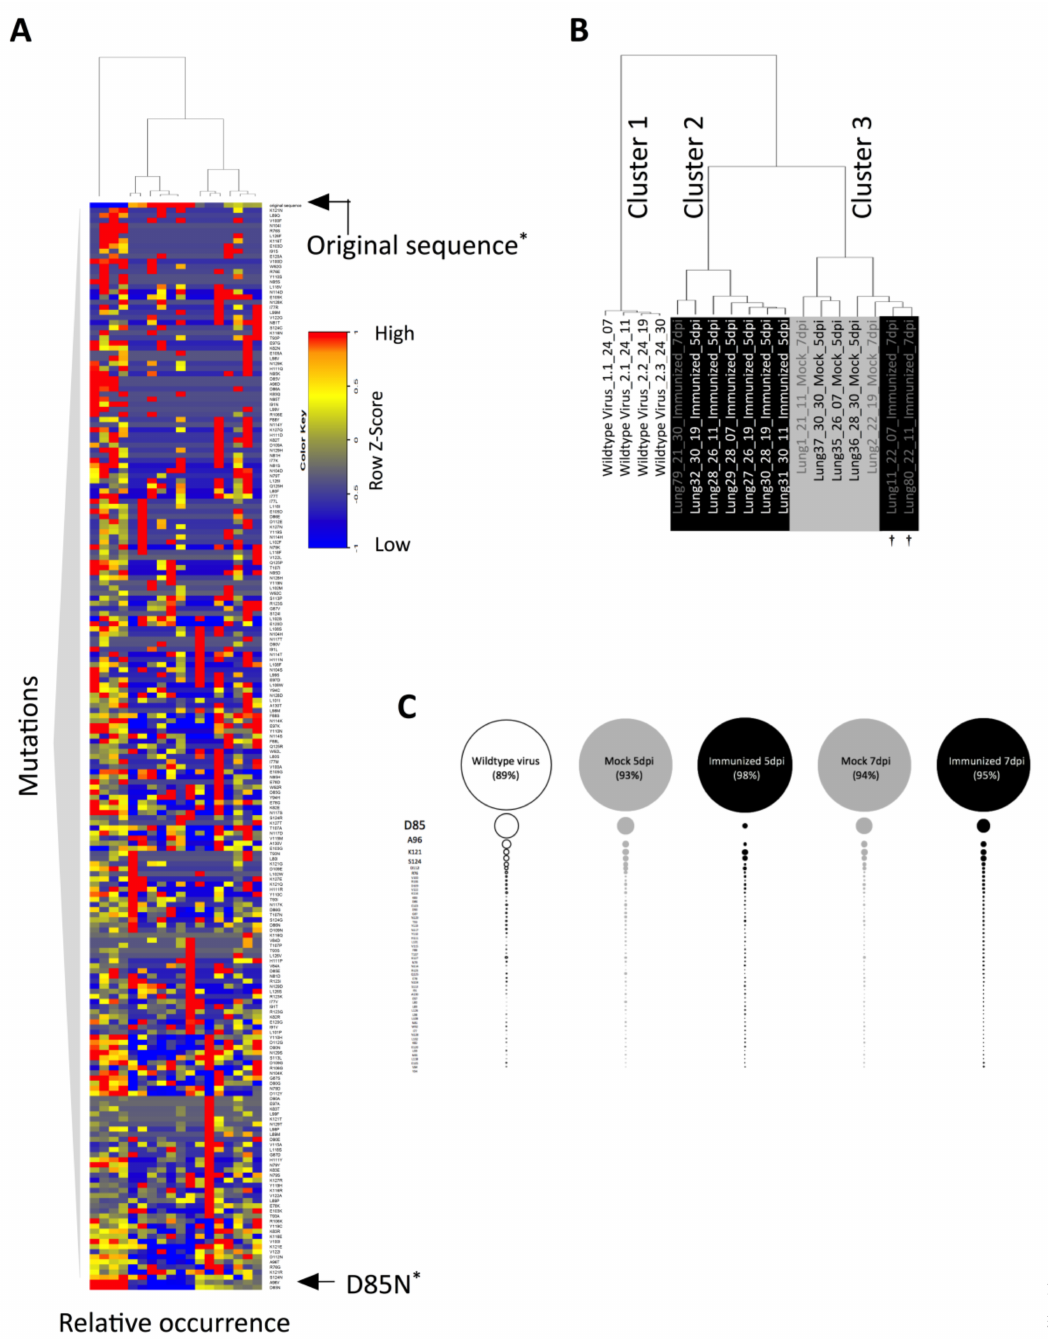
Figure 5. Constrained viral quasispecies evolution under immune pressure. ( A ) Heatmap and dendrogram of missense mutations detected in at least three out of the 18 samples analyzed by Z score based on frequency. Values from each row (i.e., mutation) have been normalized to have a mean of 0 and SD of 1. Relative expression levels of the same mutation within the individual mice are represented by the color code indicated. ( B ) Enlarged dendrogram from ( A ) using hierarchical clustering analysis performed by complete linkage and Euclidean distance measurement. †: corresponding to the samples with the same labeling in Figure 4A and Figure S2A; ( C ) Mean sequence composition of samples per group. The sizes of the bubbles are proportional to the mean percentage sample consensus sequences of each group. * p < 0.05. Error bars represent